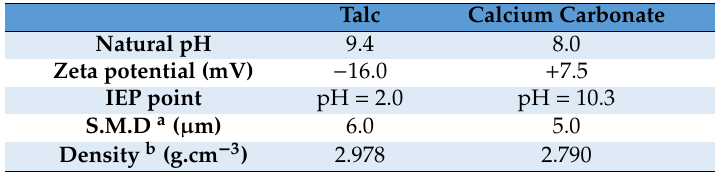
Table 1. Relevant properties and characterisation information for the two solids used.